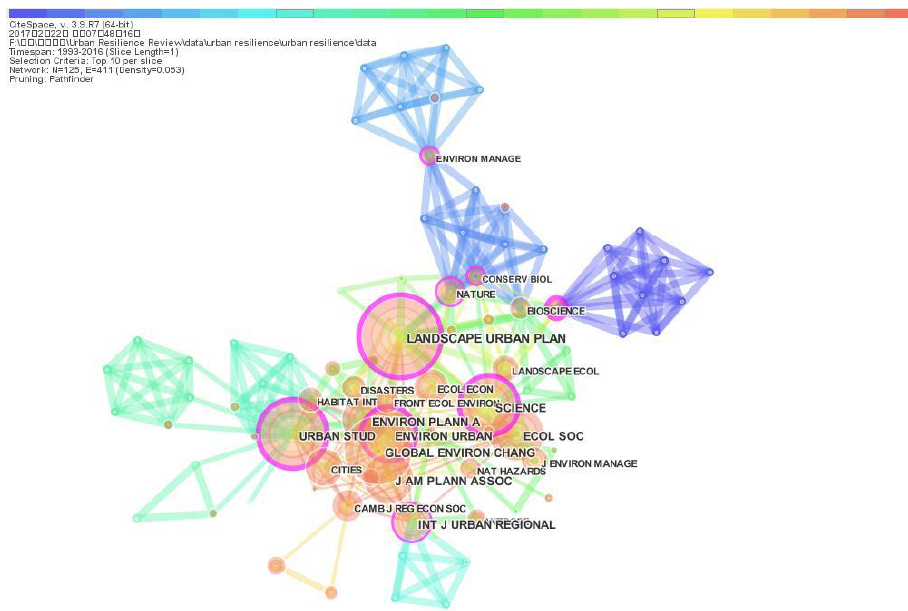
Figure 7. Journal co-citation network.